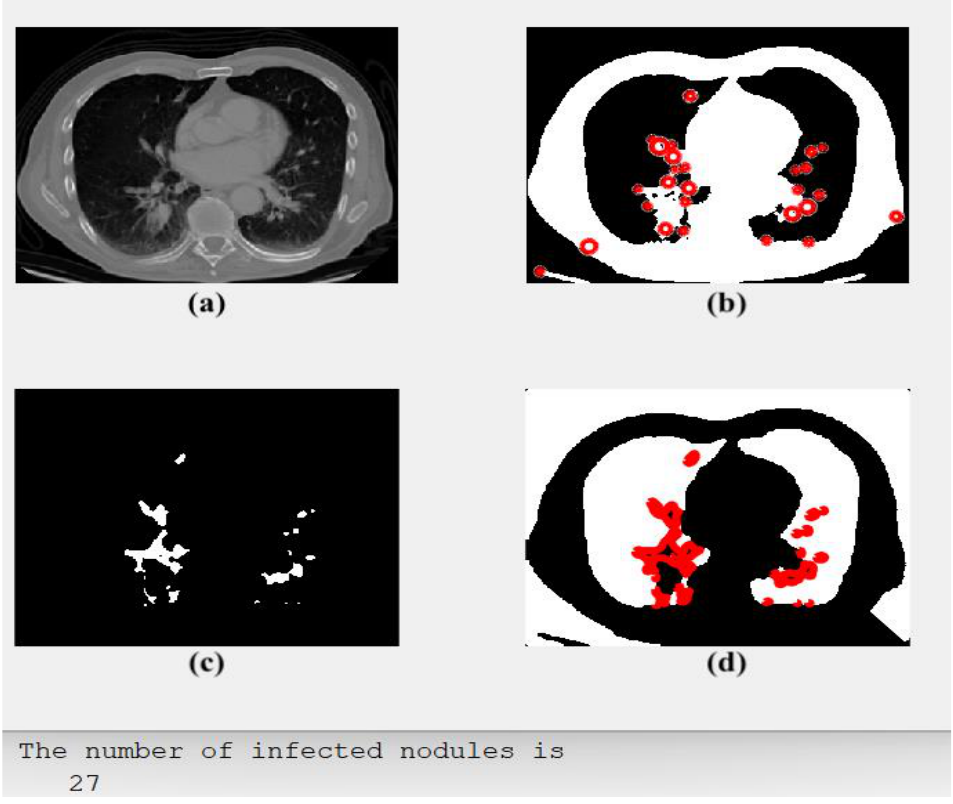
Figure 4. The obtained results of Case 2: ( a ) an input, ( b ) segmented potential RoIs, ( c ) the outlined spots, and ( d ) type of detected tumor: LCC.